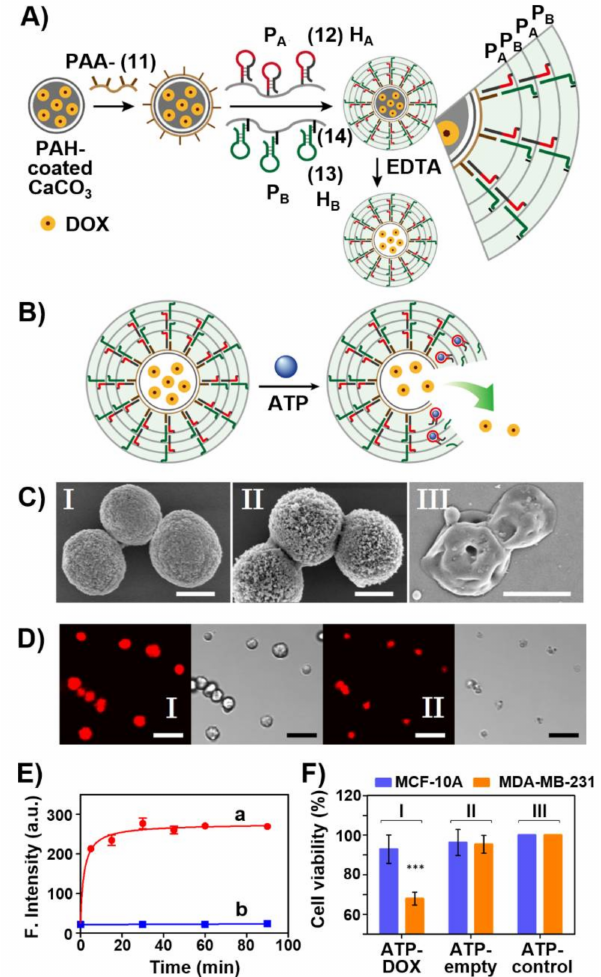
Figure 11. ( A ) Schematic preparation of doxorubicin-dextran (DOX-D)-loaded microcapsules stabi- lized by an ATP-responsive hydrogel shell created using the hybridization chain reaction. ( B ) ATP- driven release of DOX-dextran by degradation of the hydrogel shell. ( C ) SEM images of: I—uncoated DOX-D-loaded CaCO 3 microparticles; II—DOX-D-loaded ATP aptamer-bridged hydrogel-coated CaCO 3 microparticles; III—DOX-D-loaded ATP-responsive hydrogel-coated microcapsules after the dissolution of the CaCO 3 core (panel III). Scale bars, 2 µ m (I and II) and 1 µ m (III). ( D ) Con- focal fluorescence microscopy images and bright-field microscopy images of DOX-D-loaded ATP aptamer-bridged hydrogel microparticles before (I) and after (II) the dissolution of the core. Scale bar is 10 µ m. ( E ) Time-dependent release of DOX-D from the microcapsules: a. in the presence of ATP (50 mM); b. in the absence of ATP. ( F ) Cytotoxicity the DOX-D-loaded hydrogel-coated microcapsules towards MDA-MB-231 breast cancer cells (orange) and normal epithelial breast cells (blue) incubated with the microcapsules for 6 h (I), and corresponding control experiments (treatment of the cells with unloaded microcapsules (II) and nontreated cells. (III)). *** denotes p < 0.001 Reproduced